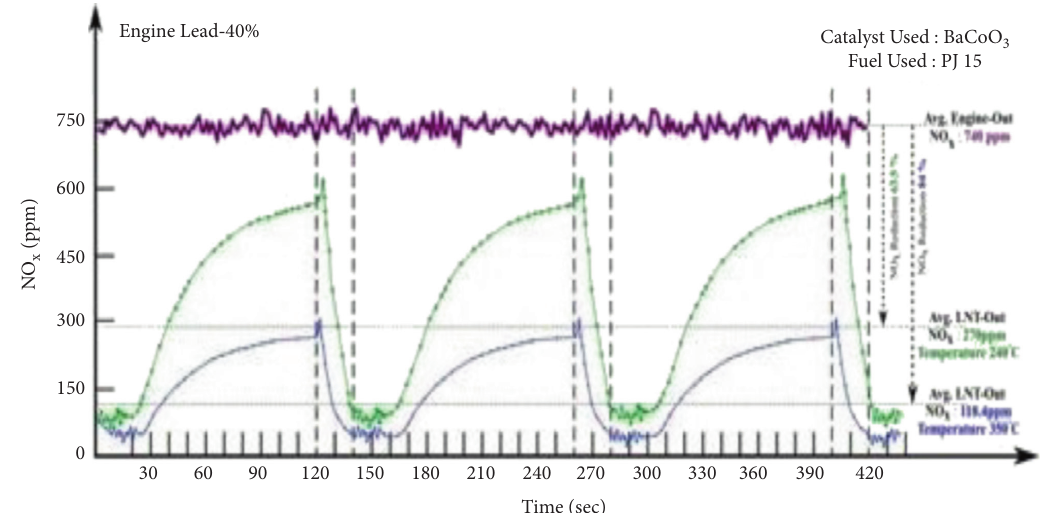
Figure 20: NO x stored in Lean phase and reduced in the rich phase by three perovskite